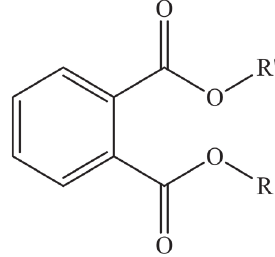
Fig. 1 – Chemical structure of